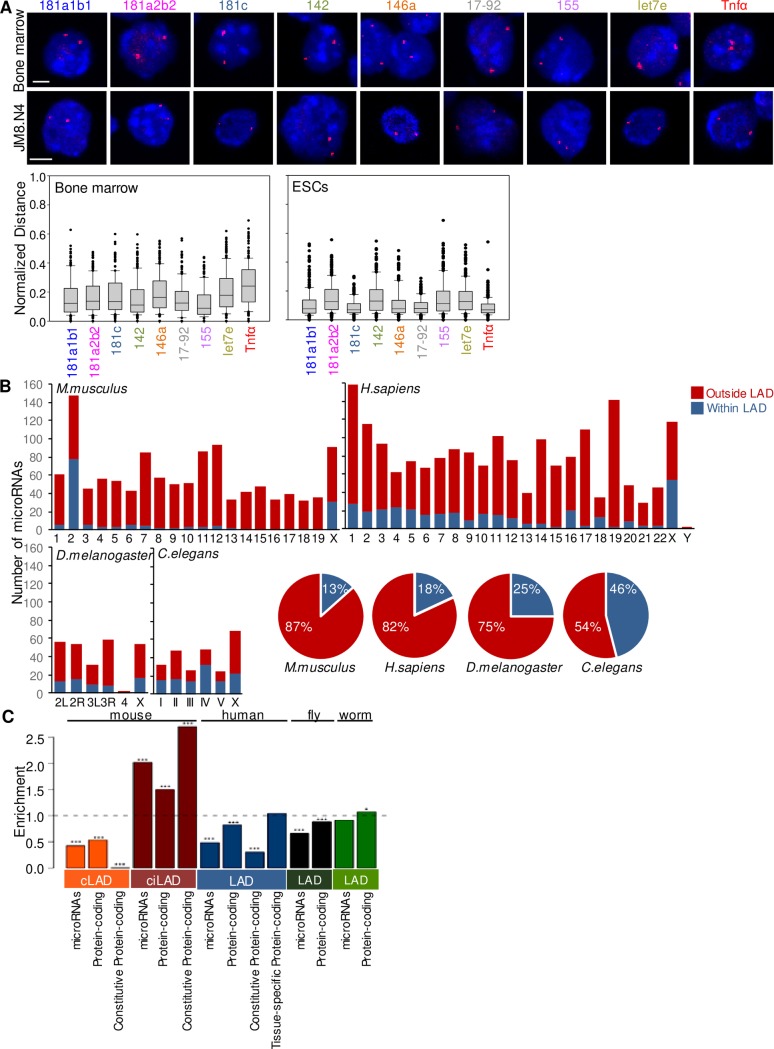
The perinuclear localization of microRNA gene loci is developmentally conserved.(A) Representative 3D DNA FISH confocal images in bone marrow and JM8.N4 ESCs. Number of nuclei assessed: bone marrow n = 200 alleles, ESCs n = 260 alleles. Scale bar 2μm. (B) Number of microRNA genes located within and outside cLADs per chromosome (Bar graphs) and total percentage of cLAD/ciLAD microRNA gene colocalization (Pie charts) in M.musculus, H. sapiens, D.melanogaster and C.elegans. (C) Enrichment values of microRNA and protein-coding genes within and outside LAD regions. Permutation p-values are depicted as ***:<0.001, **:<0.01 and *:<0.05 respectively, and calculated on the basis of 1000 permutations.